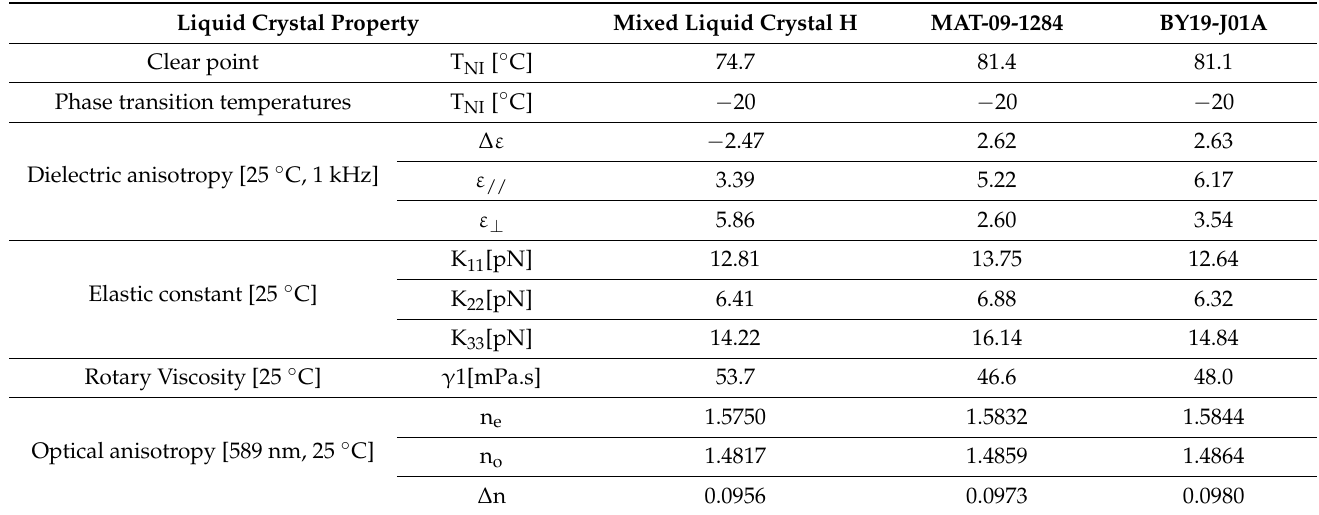
Table 4. Physical properties of the mixed liquid crystal H.